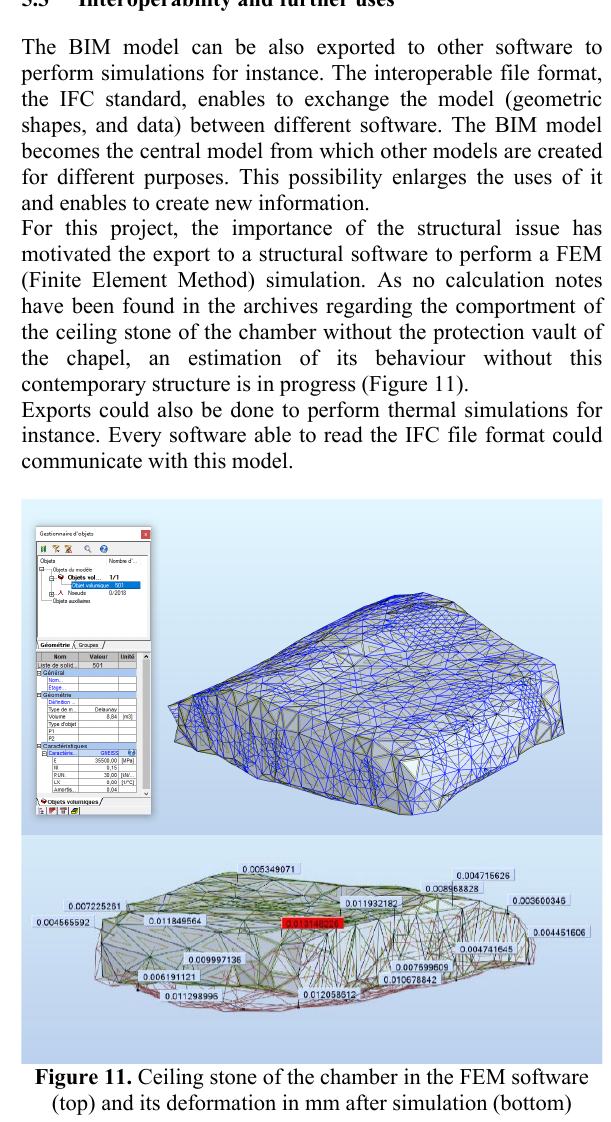
Figure 9. Example of a mapping zone and its properties